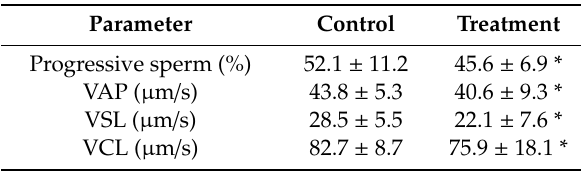
Table 1. Indicators of sperm quality.